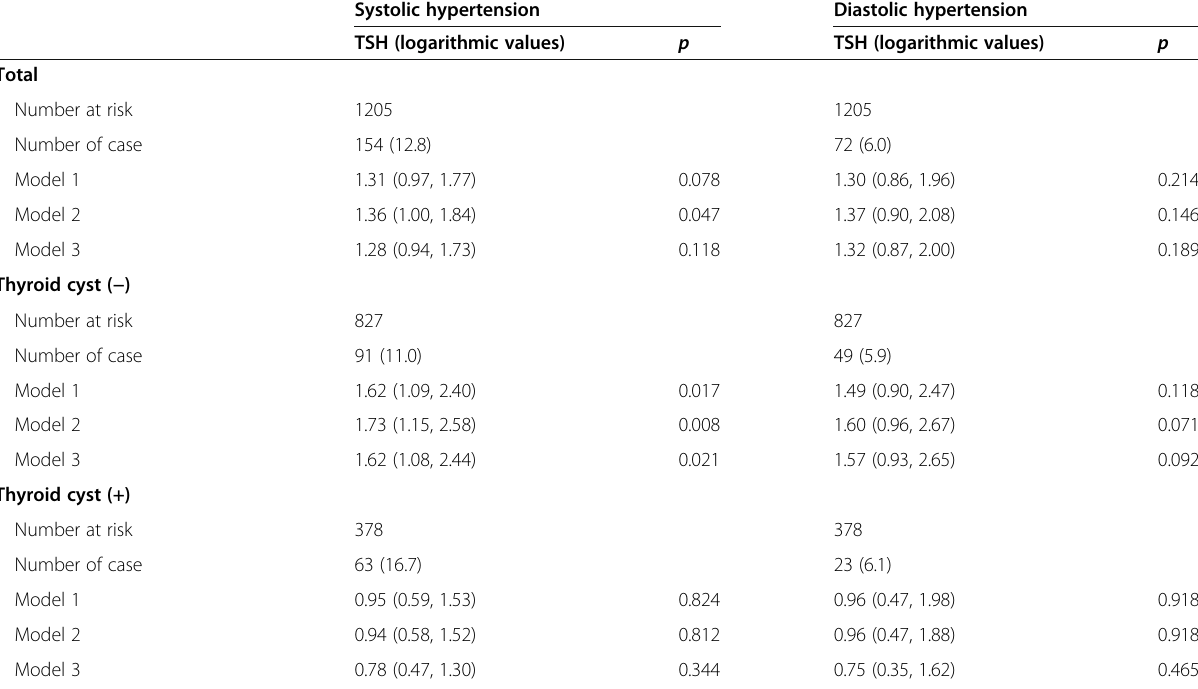
Table 4 Odds ratios (ORs) and 95% confidence intervals (CIs) for hypertension in relation to thyroid stimulating hormone (TSH) among not-taking antihypertensive medication Systolic